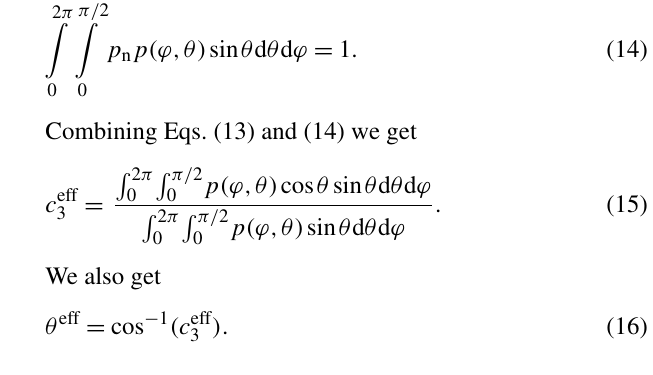
Figure 8. (a) Fabric profile along the NEEM ice core represented by the eigenvalues of the second-order orientation tensor (yellow: a ( 2 ) ) ; Eichler et al., 2013; Montagnat et al., 2014); (b) Radar echogram of HV measurements at Circle 3, adopted from red: a ( 2 ) , and blue: a ( 2 ) 2 3 Fig. 3b for visual comparison with the ice core COF. A: single max; B: elongated single max; C: transition from B to D; D: strengthened single max; E: folded